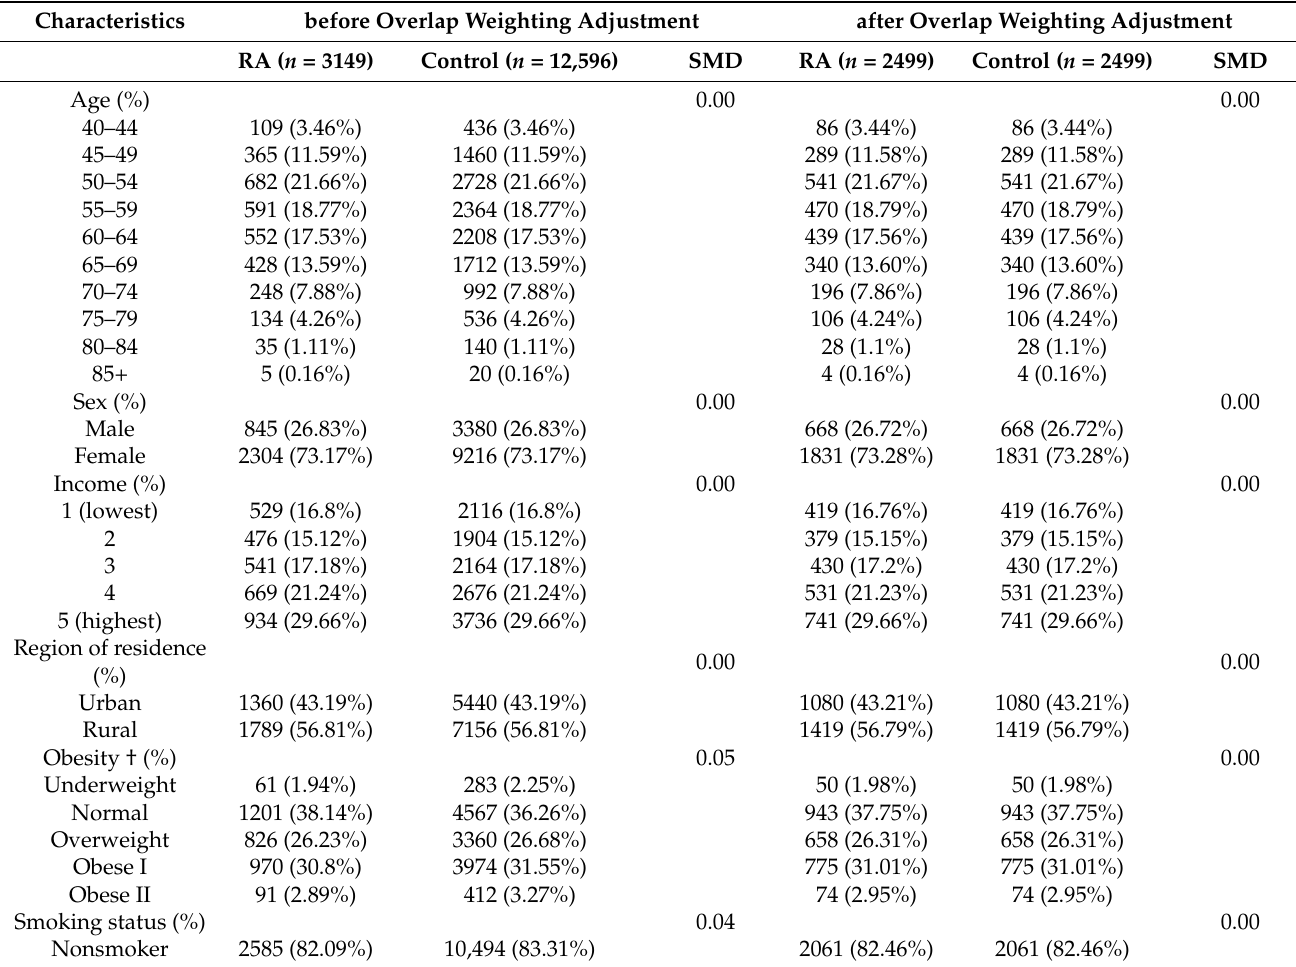
Table 1. General characteristics of